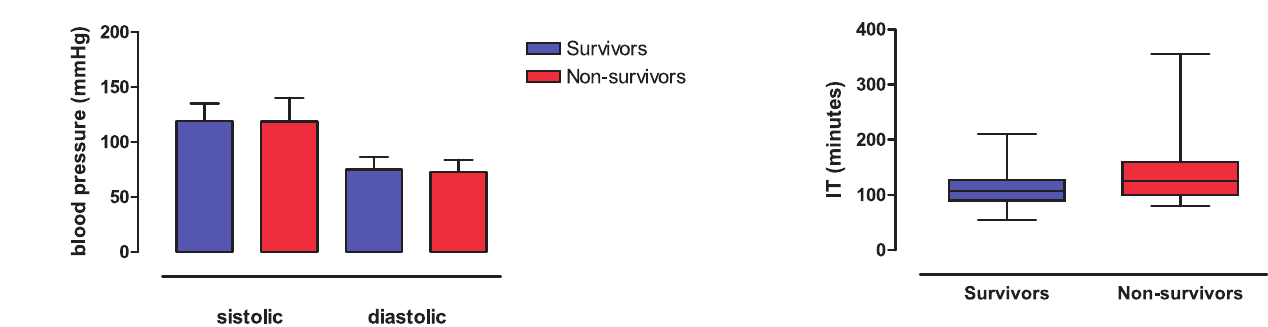
FIGURE 3 - Implant times for the patients of the survivor and non- survivor groups.